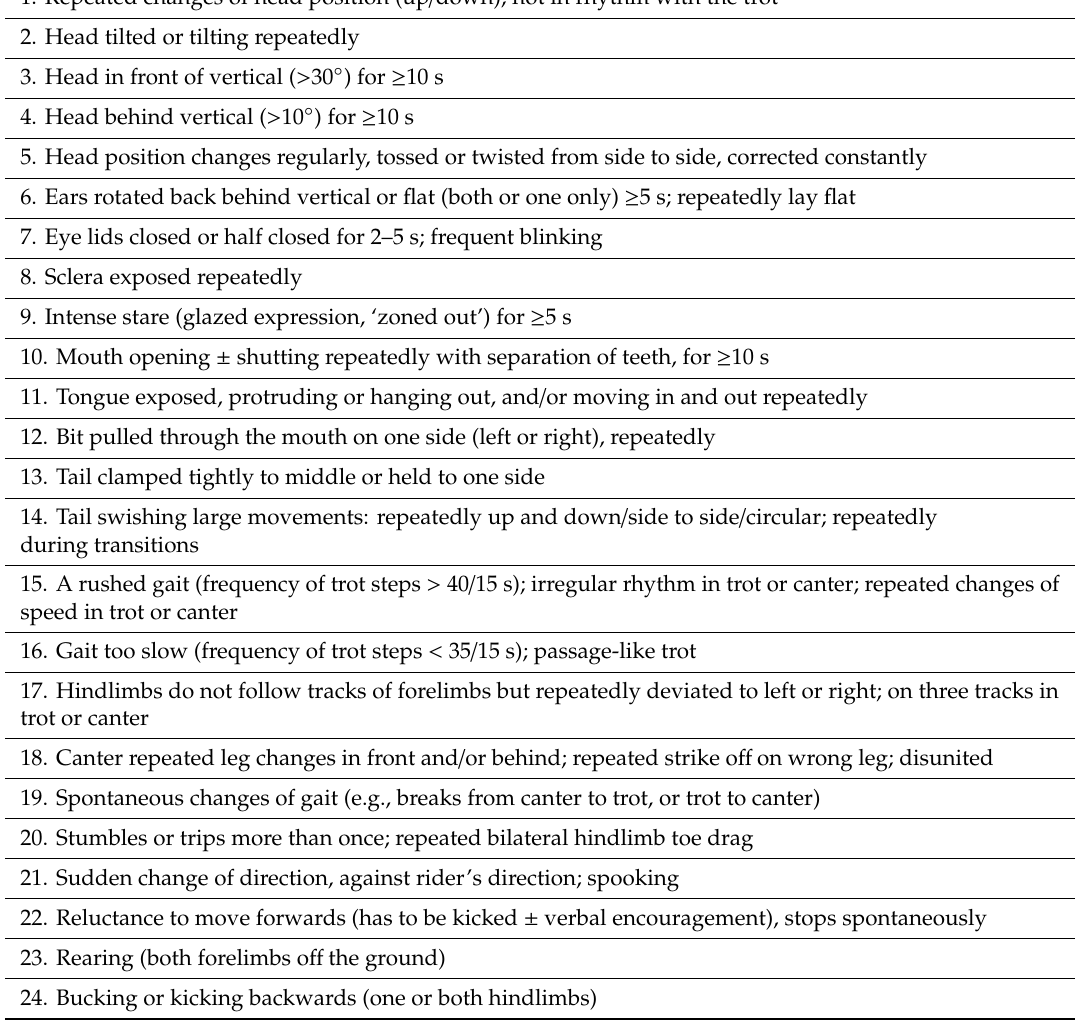
Table 1. The Ridden Horse Pain Ethogram, adapted from Dyson et al. 2018 [5]. Assessments were made in walk, trot and canter and on the left and right reins. A total behaviour score of ≥ 8 (out of 24) is likely to indicate the presence of musculoskeletal pain (Dyson et al. 2018 [5,6]). s =